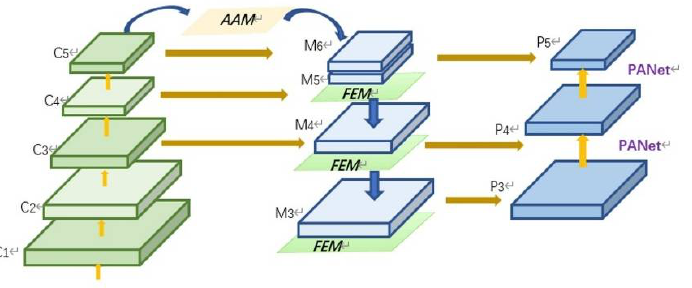
Figure 4. The structure of the AF-FPN [22].